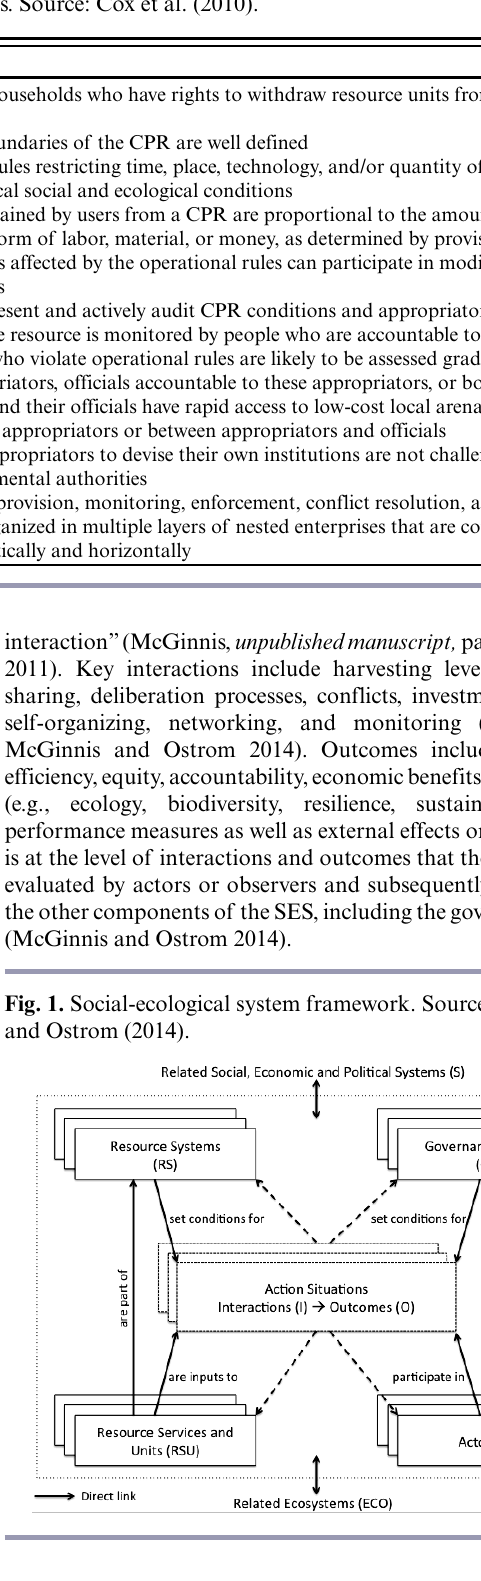
Table 1. Overview of common-pool resource (CPR) design principles. Source: Cox et al. (2010).